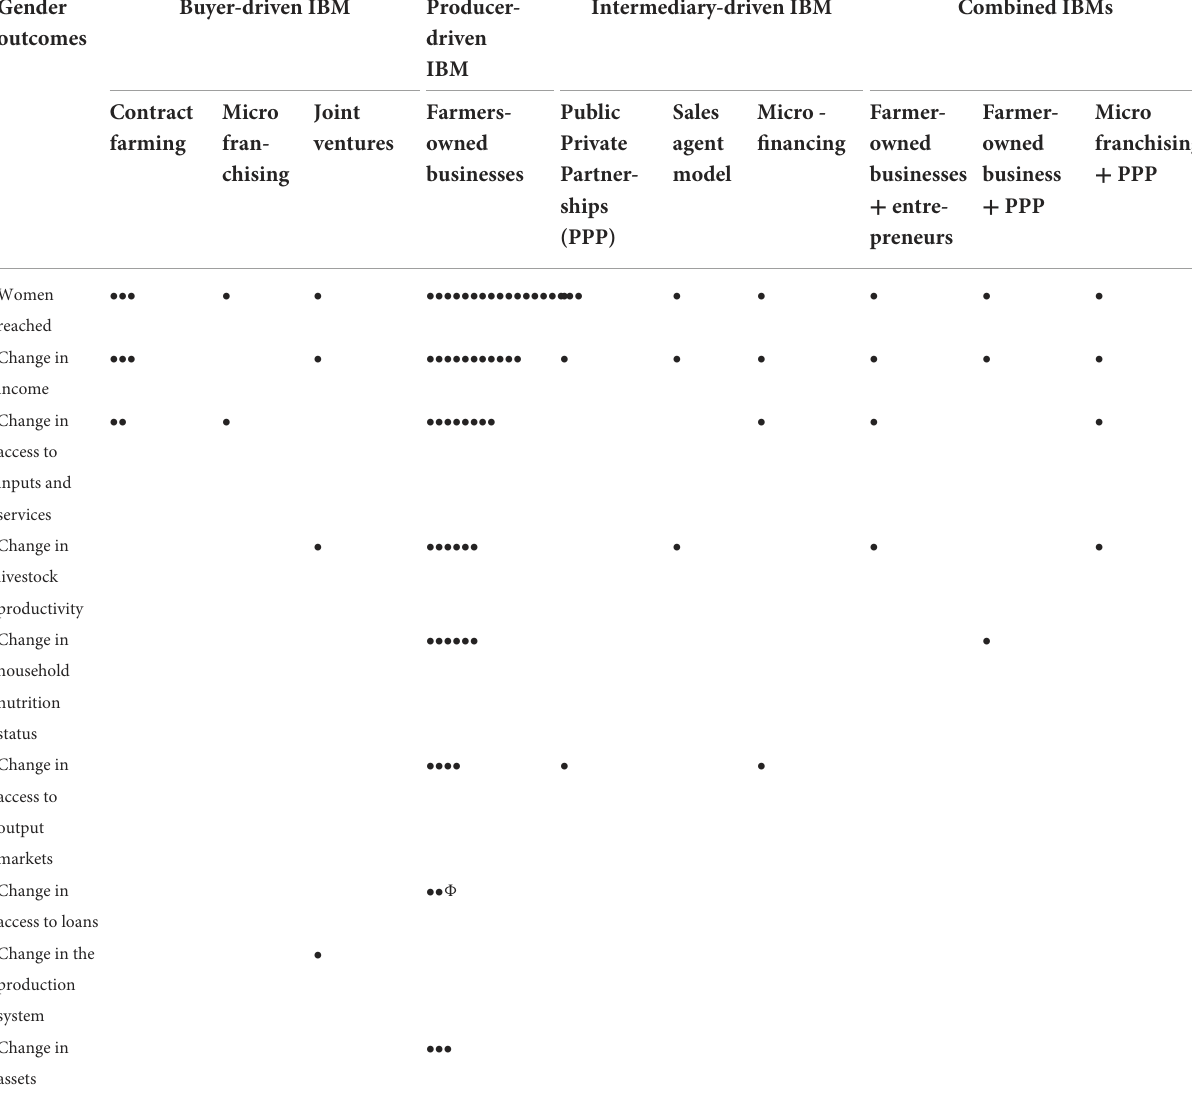
TABLE 5 Type of inclusive business model (IBM) and associated benefit